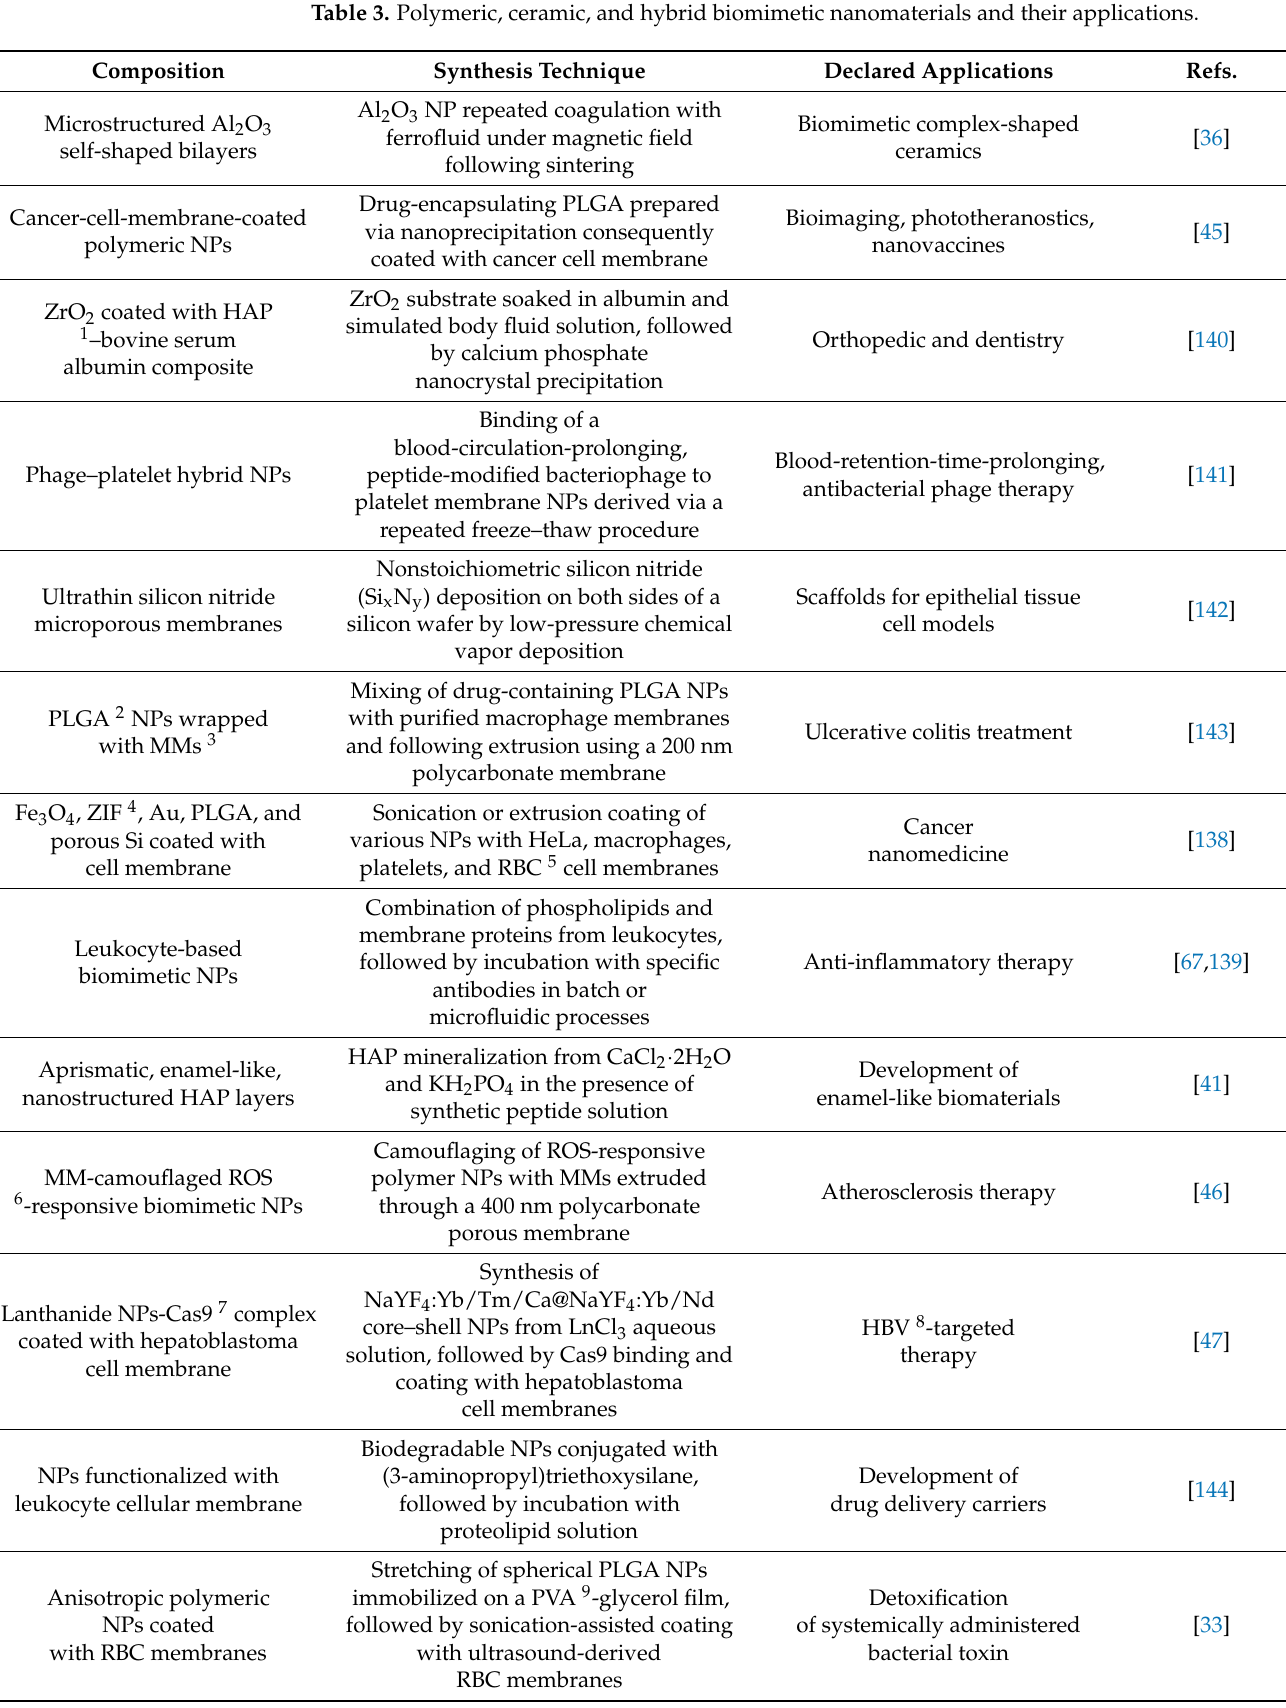
Table 3. Polymeric, ceramic, and hybrid biomimetic nanomaterials and their